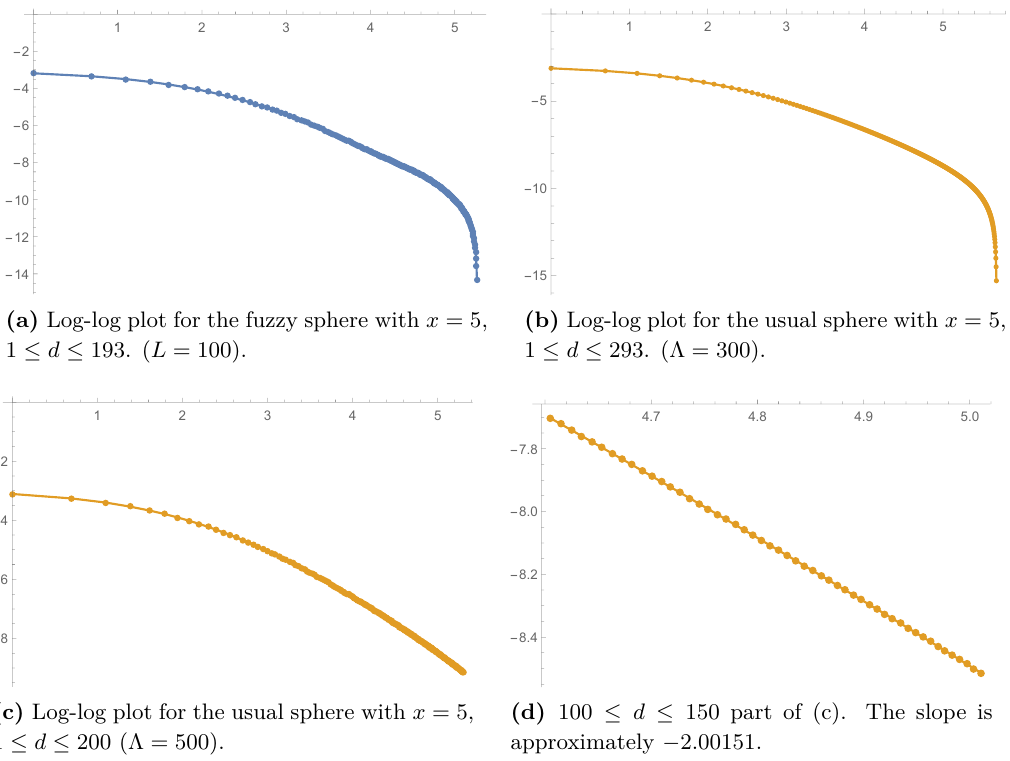
(d) 100 ≤ d ≤ 150 part of (c). The slope is approximately − 2 . 00151 . and H ( y ) . x = 5 and L H 8 R 2